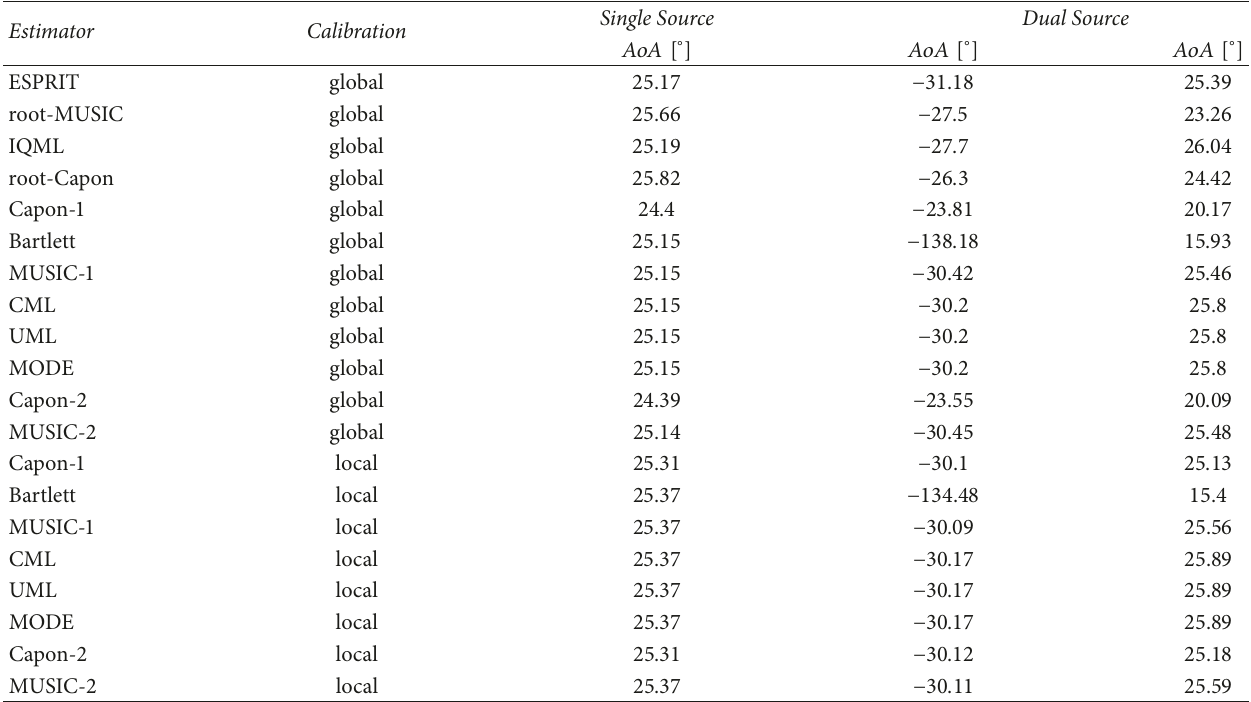
Table 6: Estimated AoAs under global and local array calibration. The setup is a single source (25 ∘ ) and a coherent dual source ( − 30 ∘ , 25 ∘ )